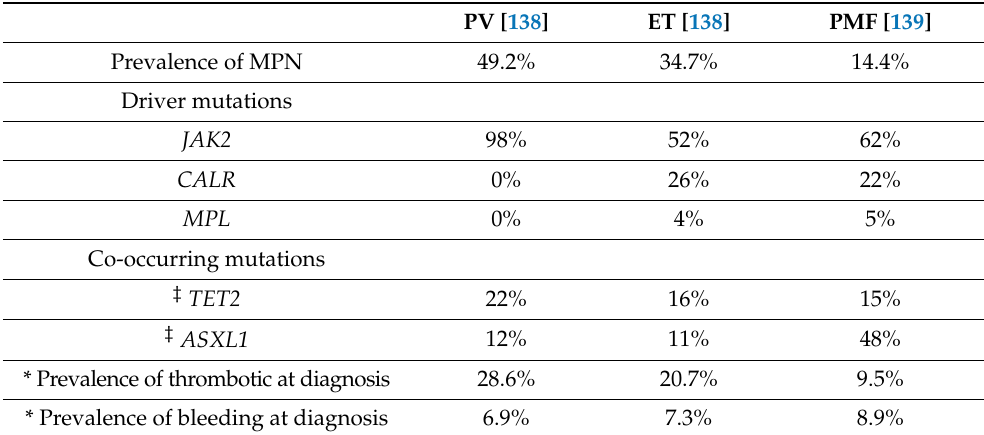
Table 2. Molecular characteristics of PV, ET and